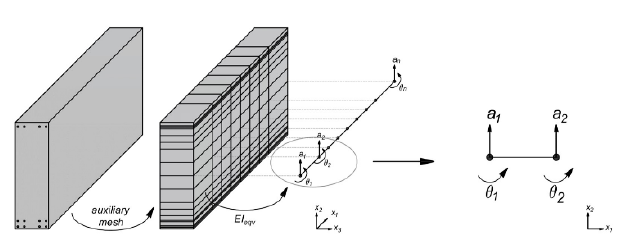
Figure 2. Consider of other dimensions, physical parameters, and local refinement in laminated Euler-Bernoulli beam